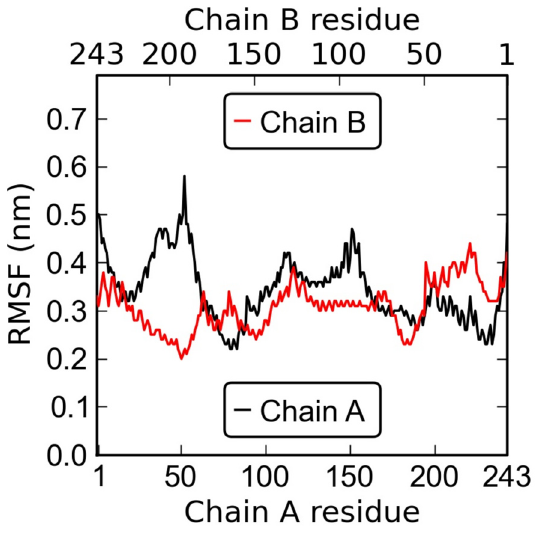
Figure 7. Root mean square fluctuation (RMSF) profiles for apoA-I alpha carbons (black, chain A; red, chain B) measured over the last 4 m s of the simulation of the full HDL particle. Experiments suggest that the alpha-helical region is likely given by the residues 44–241, and that the alpha-helical content overall is about 75– 80% [6,13,18,26].